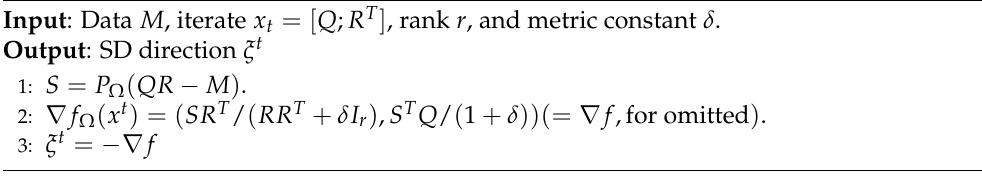
Algorithm 2 Steepest descent (SD) direction of the function in (9) with orthogonality of Q